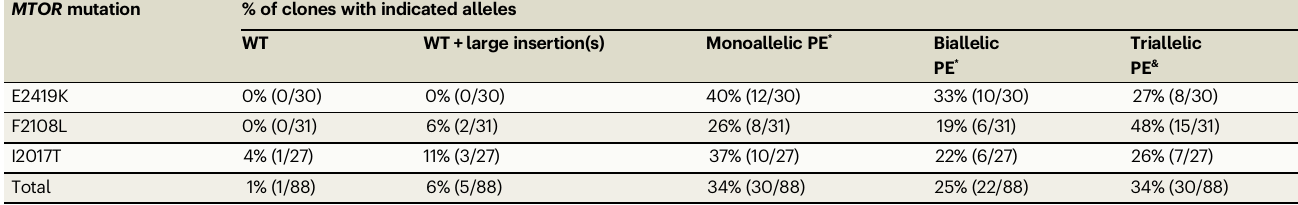
Table 1 | Distribution of alleles in single cell-derived clones edited at MTOR by co-selection MTOR